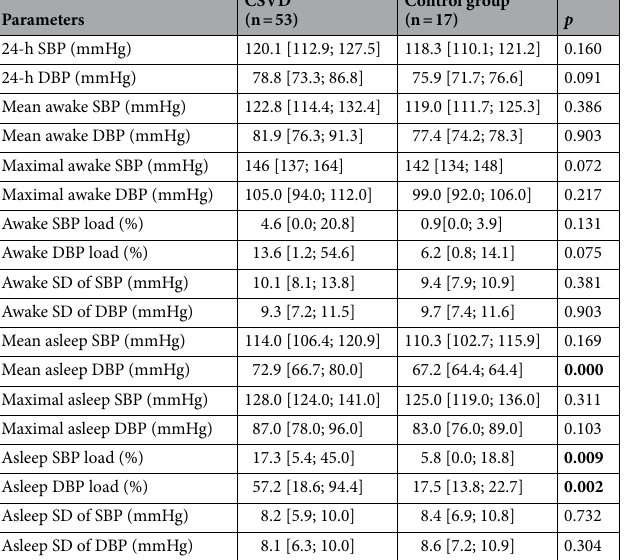
Relationships between the standard deviation of blood pressure, which correspond to the indices of variability, and neuroimaging markers of CSVD were not found either by comparative or correlation analysis, therefore these data are not included in the table. To clarify the link between daily blood pressure fluctuations and BBB permeability, the last one was assessed using DCE-MRI in patients and controls (Fig. 2). According to DCE-MRI, all the study parameters of BBB permeability in NAWM and GM, except for Ktrans in NAWM, were significantly higher in patients with CSVD than in controls. BBB permeability decreased as WMH Fazekas score increased, with significant differences in Vp and AUC in WMH (Table 5). Differences in the BBB permeability parameters in GM and NAWM depending on the WMH Fazekas score were not found. Statistically significant correlations were seen between AUC in GM and NAWM, Vp in NAWM and the parameters of 24-h and awake SBP and DBP (Table 6).